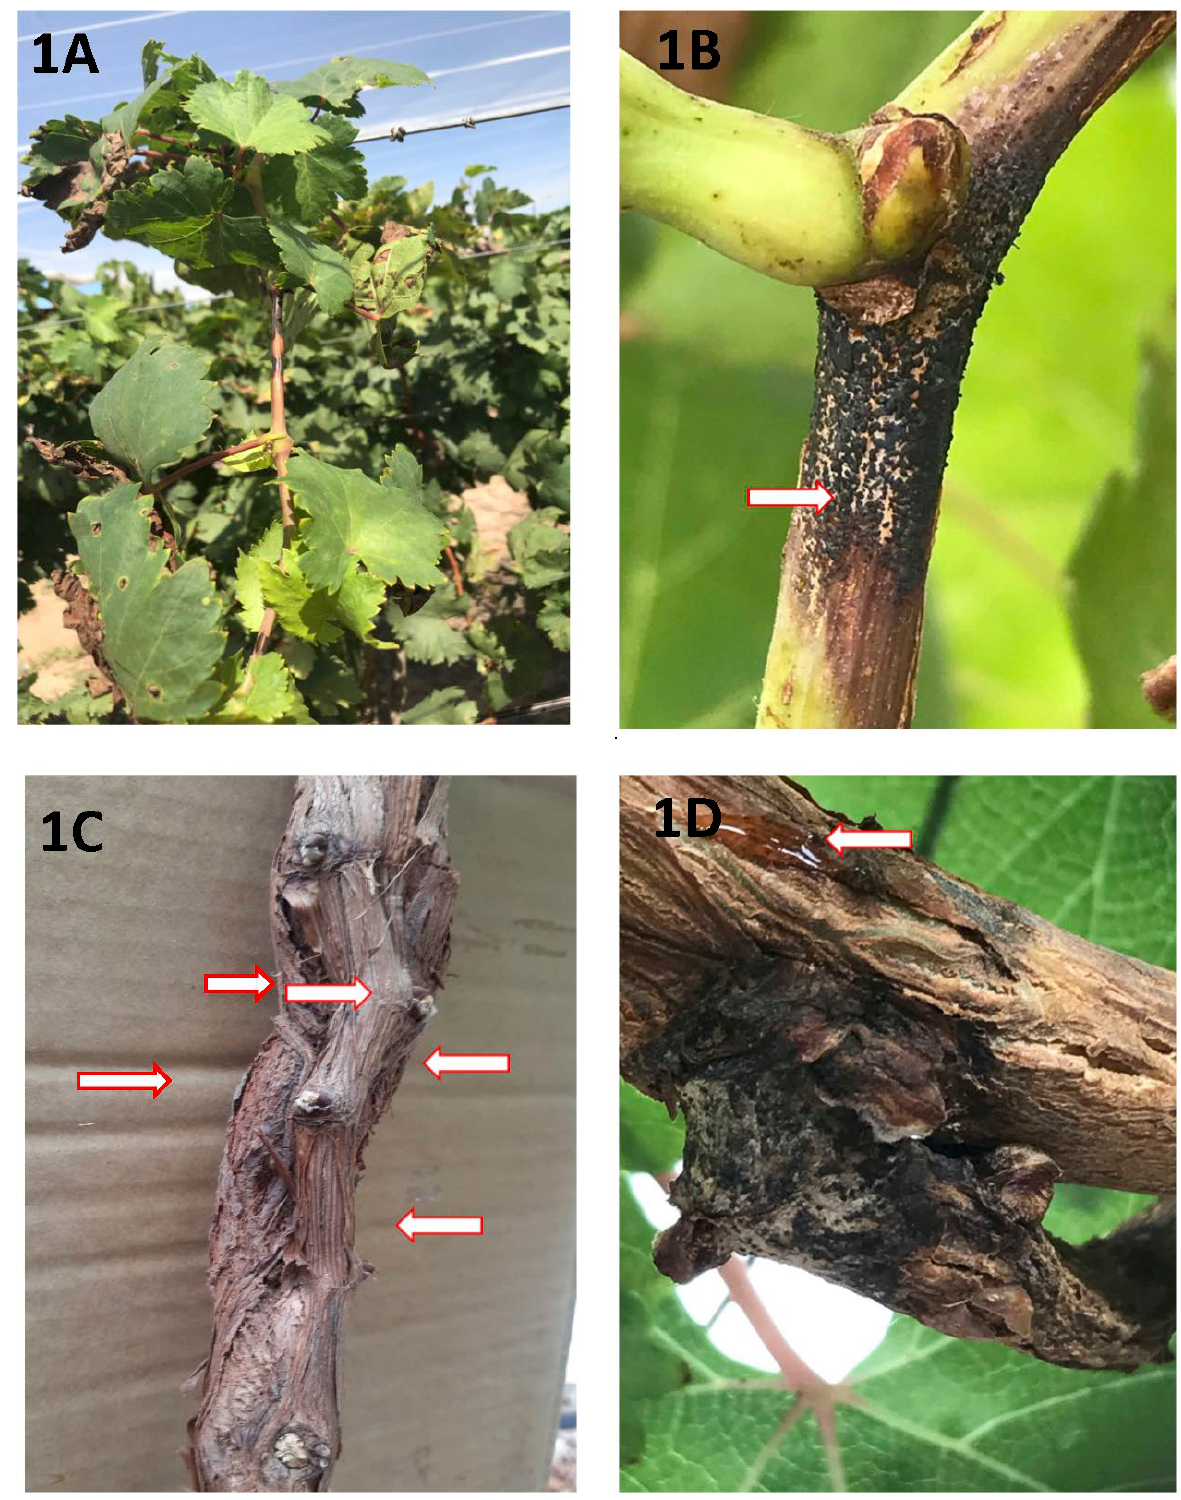
Figure 1. Grapevine trunk diseases caused by Greeneria uvicola . The arrows indicate details of the symptoms and damage. 1A: Beginning of the disease in young branches (leaves and stems). 1B; Greeneria uvicola acervuli around one shoot. 1C; Dead branch with pronounced can- ker, twist deformed stem, and presence of acervuli. 1D; Gummosis in dead